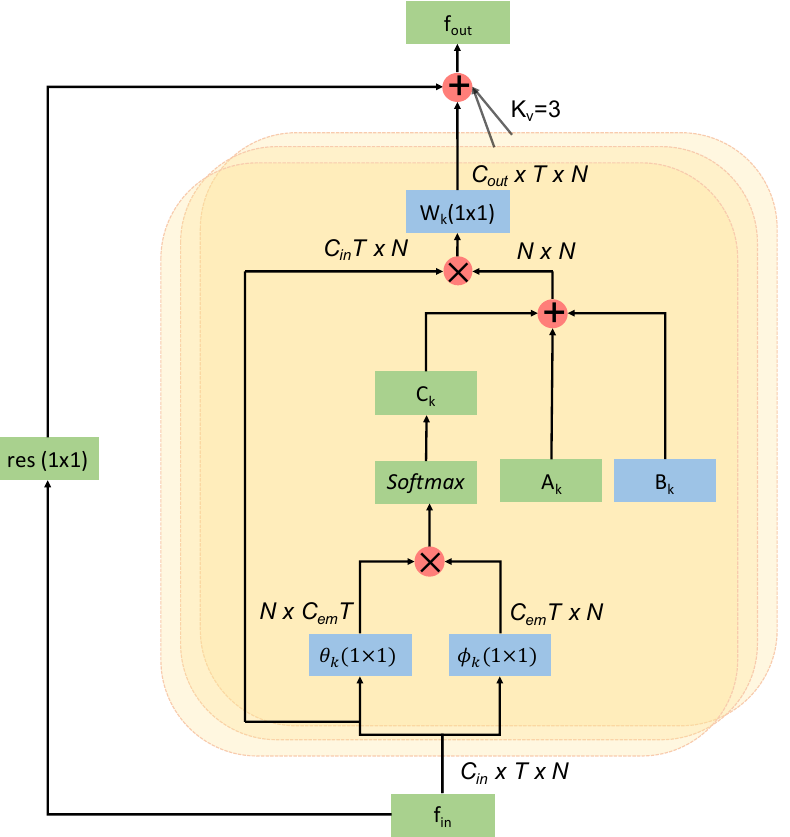
Figure 4. Architecture of an adaptive graph convolutional